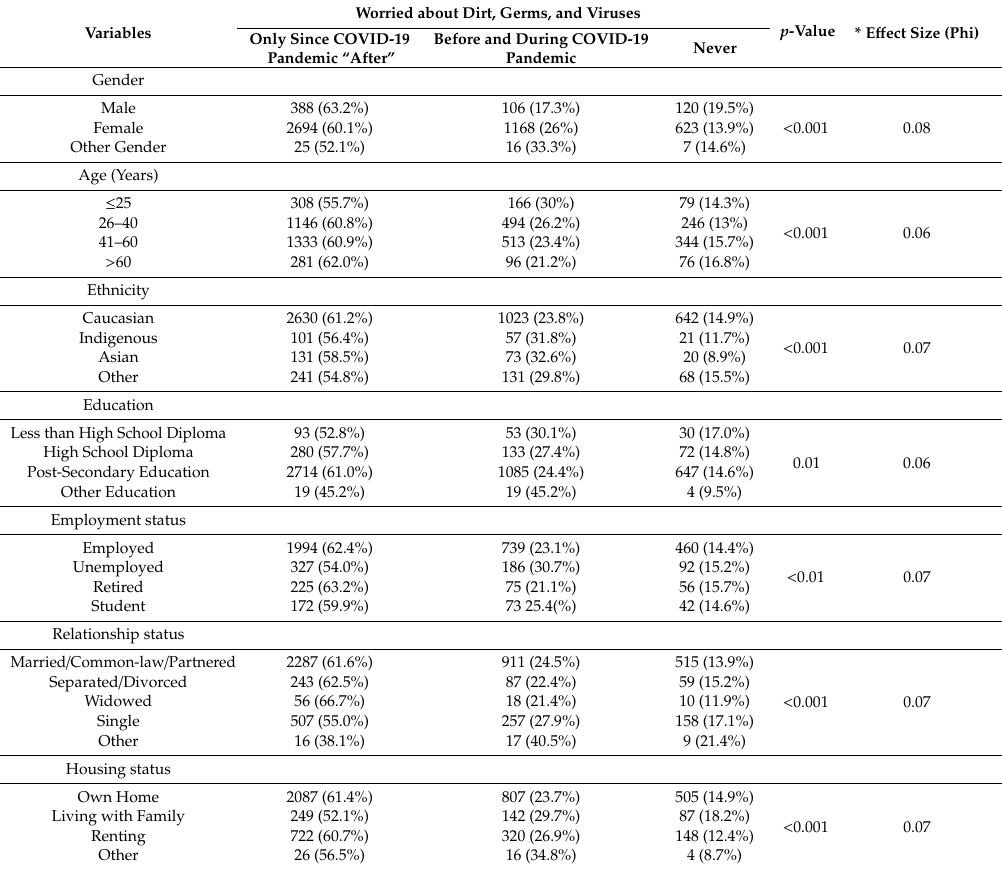
Table 2. Demographic characteristics of respondents with obsessive symptoms (dirt, germs, and